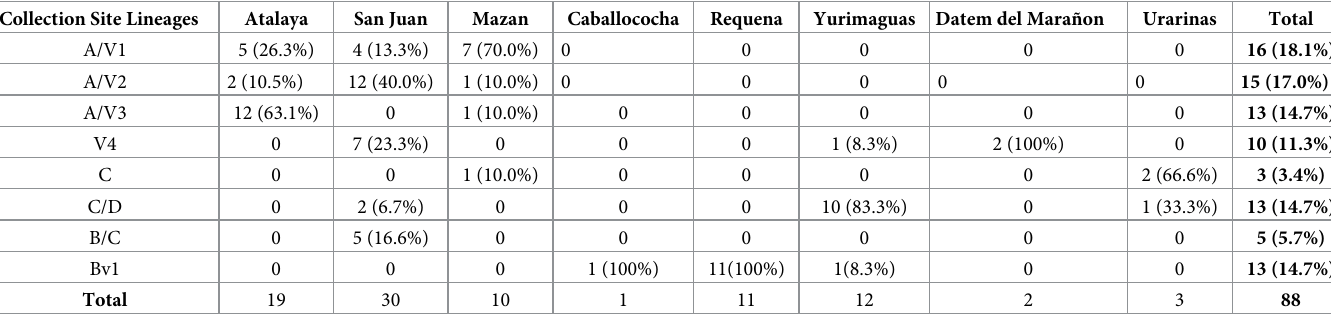
Table 4. Frequency of lineages identified in the Peruvian collection sites. Collection Site